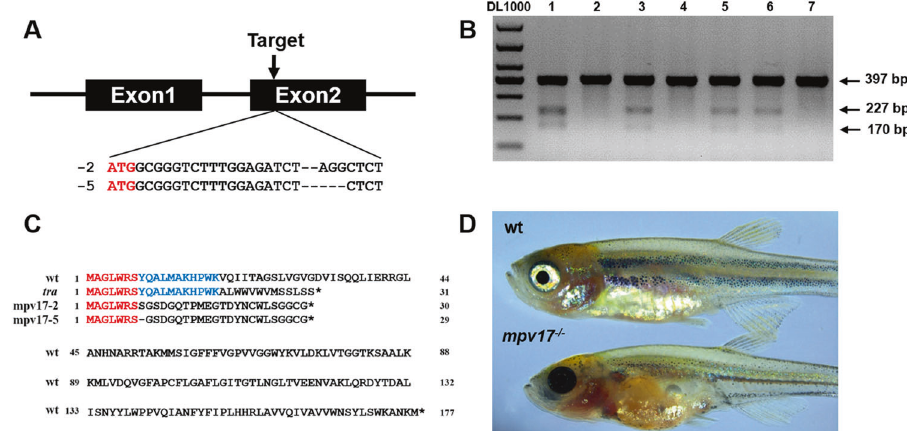
Fig. 1 The zebra fi sh mpv17 gene was knocked out using the CRISPR/Cas9 system. A The targeted loci were near the translation start code ATG of the gene mpv17 . B The agarose gel electrophoresis results of the T7E1 assay for the screening of mpv17 knocked out zebra fi sh. The marker is DL1000 and the lane number shows different samples. The 397 bp band indicates the wild-type gene, and the lanes with 227 and 170 bp bands show the mutated genes. C The amino acid alignment of the mpv17 protein sequence in wild-type, tra mutant, and mpv17 − / − zebra fi sh in this study. D One-month-old wild-type and mpv17 − / − zebra fi sh